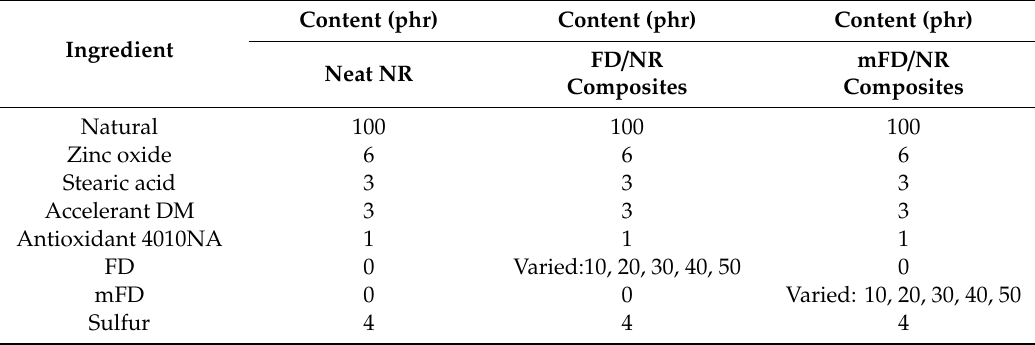
Table 1. Compound recipe of the natural rubber (NR)